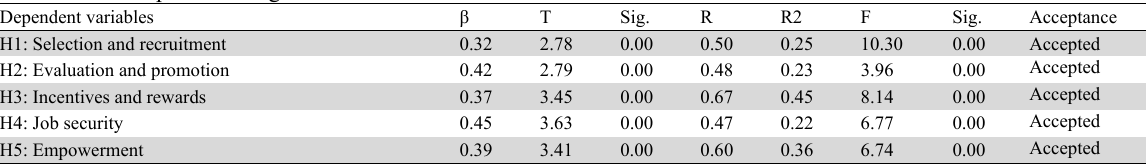
The results of simple linear regression Dependent